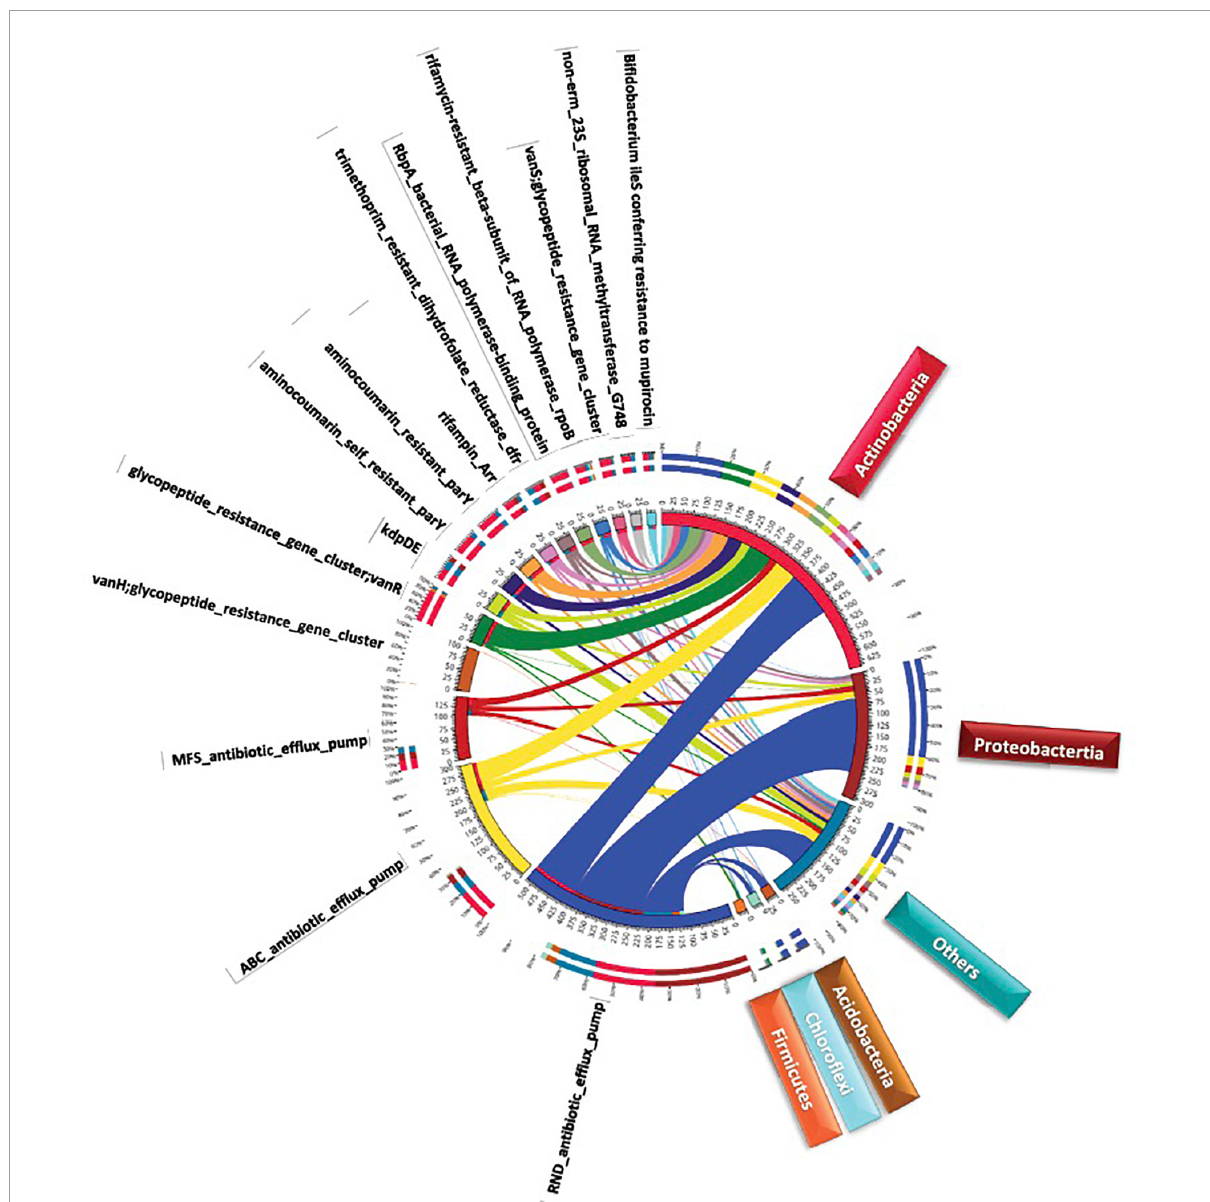
FIGURE5 Circle chart of metabolic processes at the bacterial phylum level of the top highly abundant antibiotic resistance genes ( > 20 ORFs/ARG) in different samples of rhizosphere and bulk soil microbiome s surrounding Moringa oleifera. The chart is divided into two sides, where the right one refers to bacterial phylum information and the left refers to metabolic processes information. The wideness of different scales in inner and outer circles refers to relative abundances of metabolic processes and bacterial phylum. Colors in inner circle refer to sum of relative abundance of all metabolic processes per bacterial phylum (right side) ai1d sum of relative abundance of all bacterial phyla per metabolic process (left side) . While, colors in outer circle refer to detailed relative abundance of different metabolic processes per bacterial phylum (right side) and detailed relative abundance of different bacterial phyla per metabolic process (left side)